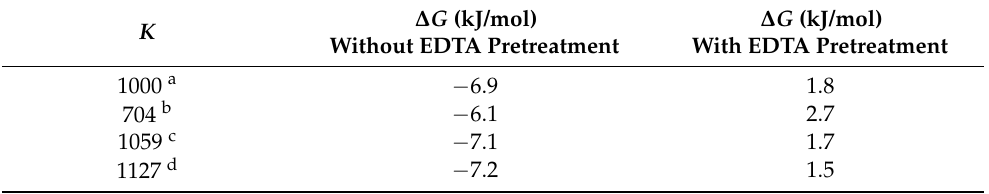
Table 2. Calculation results of the change in free energy with and without EDTA pretreatment.